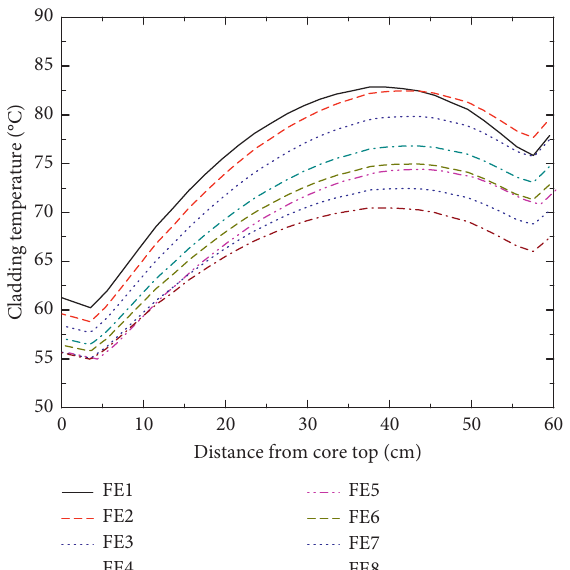
Figure 10: Axial profile of cladding temperature of the FEs in the hottest assembly. The FEs are numbered from outer to inner FEs in the